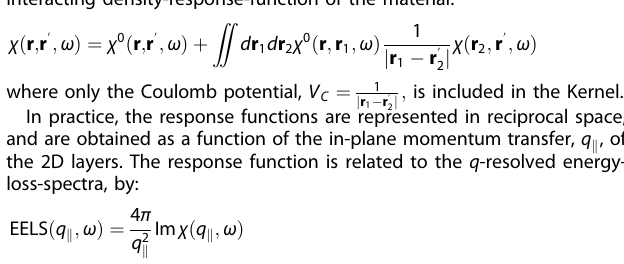
Fig. 5 Effect of electron beam geometry and number of layers studied using time-dependent density-functional-theory (TDDFT) in the random phase approximation (RPA) and compared to experimental monochromated LL-STEM-EELS. a EEL spectra of 1 – 3 layers of freestanding MoS 2 found using RPA. The q -resolved RPA spectra shown here are calculated for the q || in the Γ -M direction of the 2D Brillouin zone and normalised to the number of layers. RPA gives a good description of plasmons but not of excitons due to exclusion of electron – hole interactions, essential for excitons. For q || = 0 no difference was found with increasing N . Once the corrections are applied, the energy-loss is found to set in at ~ 3 eV (iii). For larger q, however, the spectra diverge for increasing N . Hence for non-zero q , peaks associated with plasmons come in at ~ 8.3 eV (iv) and ~ 14 eV (v). The peaks in the spectra associated with the plasmons also blueshift. Hence, the differences in the spectra with increasing number of layers as observed experimentally are due to beam geometry. The beam is probing a large range of q in plane across the sample, however, as the structure becomes 3D (with increasing number of layers) the beam is also increasingly probing out- of-plane excitations and as a consequence, the shape of experimental spectra changes with increasing number of layers. b The spectra summed over q contributions is shown here with q max = 2.0A-1. When comparing the spectrum for q = 0 and the spectrum for summed q up to q max , there is a peak at ~ 8.3 eV (iv) as well as at ~ 14 eV (v) that become prominent in the latter spectra. When compared to experimentally acquired spectra as shown in c , the peaks at ~ 3 eV (peak iii), the peak at ~ 8.3 eV (peak v) as well as the peak at ~ 14 eV (peak v) show a nice correspondence between experiment and calculations. In addition, the ~ 3 eV peak (iii) is present in all of the experimental as well as calculated spectra. The peak at ~ 8.3 eV is present in our calculated spectra for fi nite q as well as in some of the experimental spectra, where the peak appears and increases with increasing number of layers, supporting our earlier hypothesis about the beam probing an increasing contribution from q out-of-plane with increasing thickness (increasing number of layers N ). d The spectra were also calculated for increasing number of layers N (for N = 1,2,3,5). The contribution from q = 0 spectrum to the summed spectra grows proportional with N . The plasmon peaks were also found to blueshift with increasing